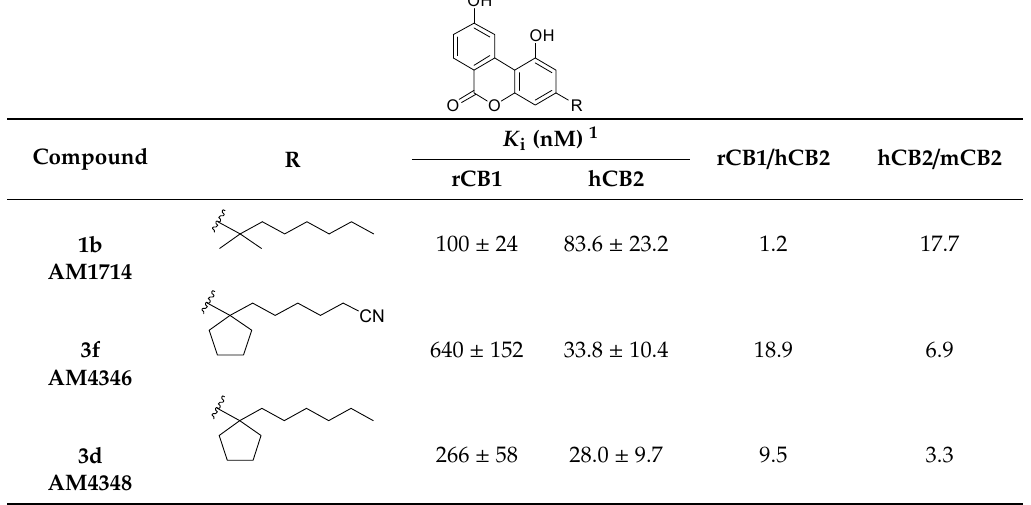
Table 2. Affinities of key cannabilactone analogs for hCB2 cannabinoid receptors (± 95% confidence limits).